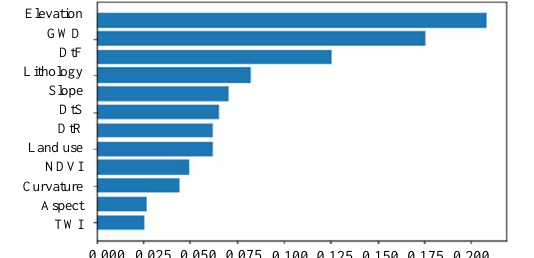
Figure 5. XGboost Feature importance based on